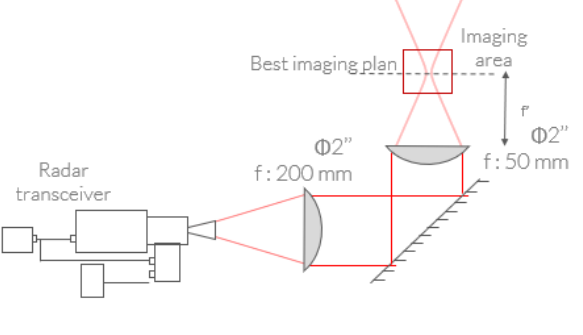
Figure 11. Typical optical setup for FMCW radar nondestructive imaging in far-field